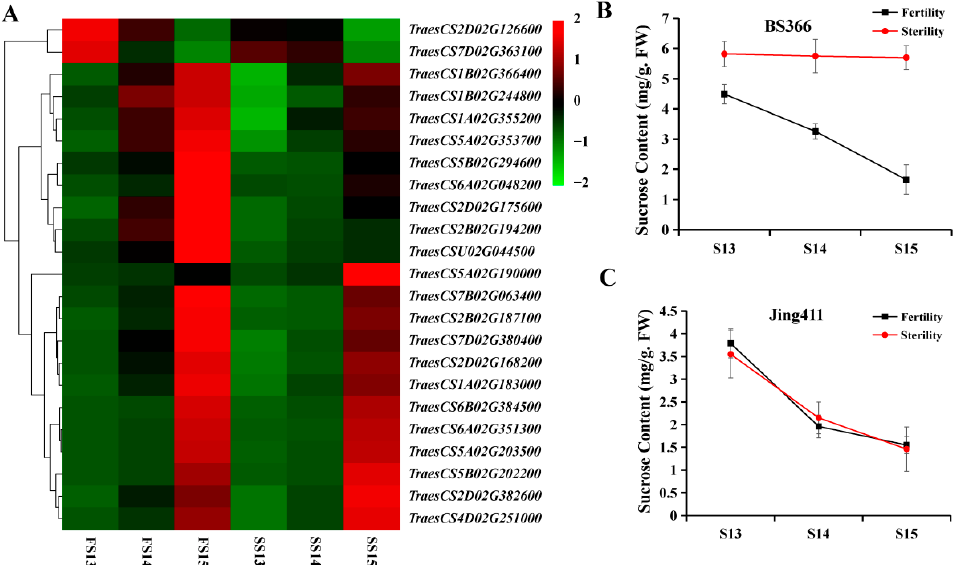
Figure 4. Expression levels of DEGs of the starch and sucrose metabolism pathway of BS366 in the blue module of WGCNA and sucrose contents of BS366 and Jing411 under fertile and sterile condi- tions. ( A ) Heatmap of the DEGs of the starch and sucrose metabolism pathway of BS366 in the blue module of WGCNA. ( B ) Sucrose contents of anthers of BS366 under fertile and sterile conditions during the later anther development. ( C ) Sucrose contents of anthers of Jing411 under fertile and sterile conditions during the later anther development.